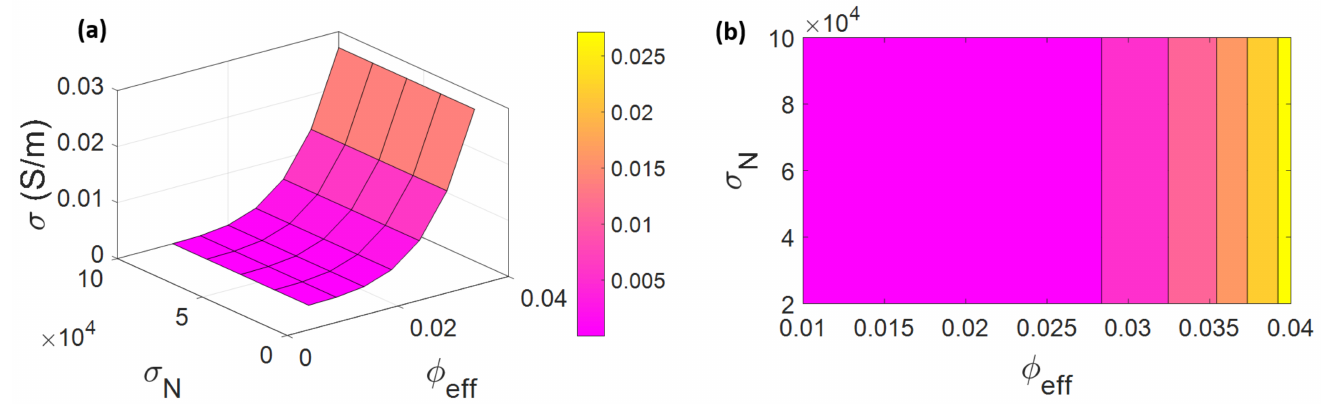
Figure 6. ( a ) Three-dimensional and ( b ) two-dimensional plots for the conductivity at various levels of “ ϕ ef f ” and “ σ N